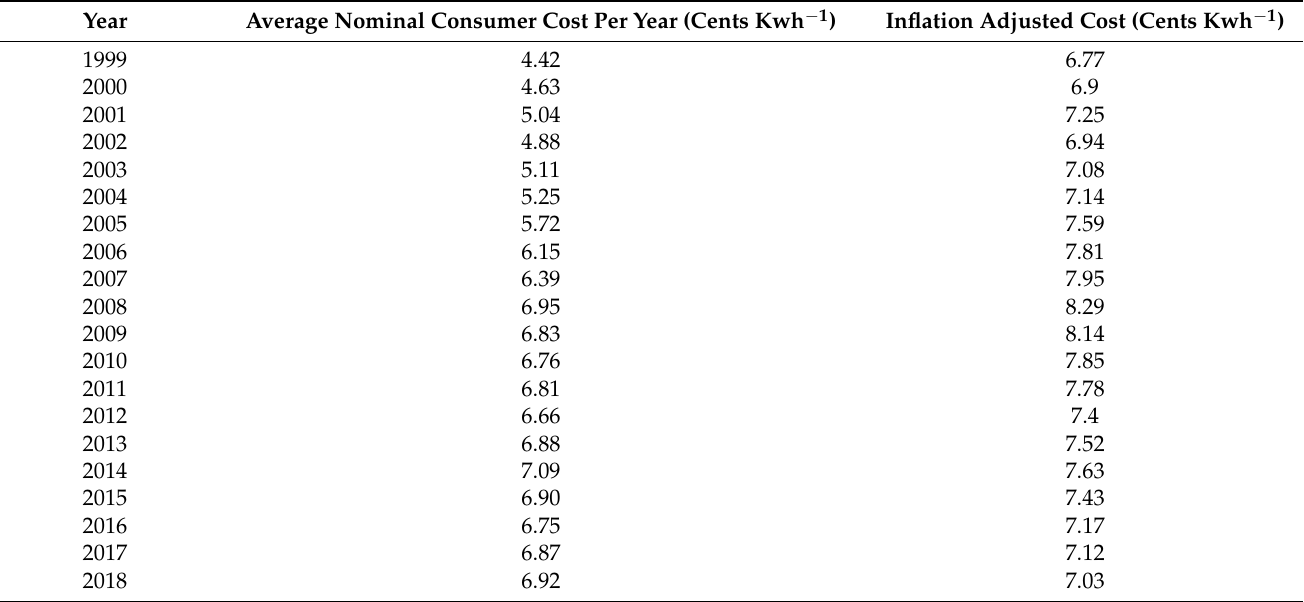
Table A10. Annual United States national industrial grid electricity costs 1999–2019.